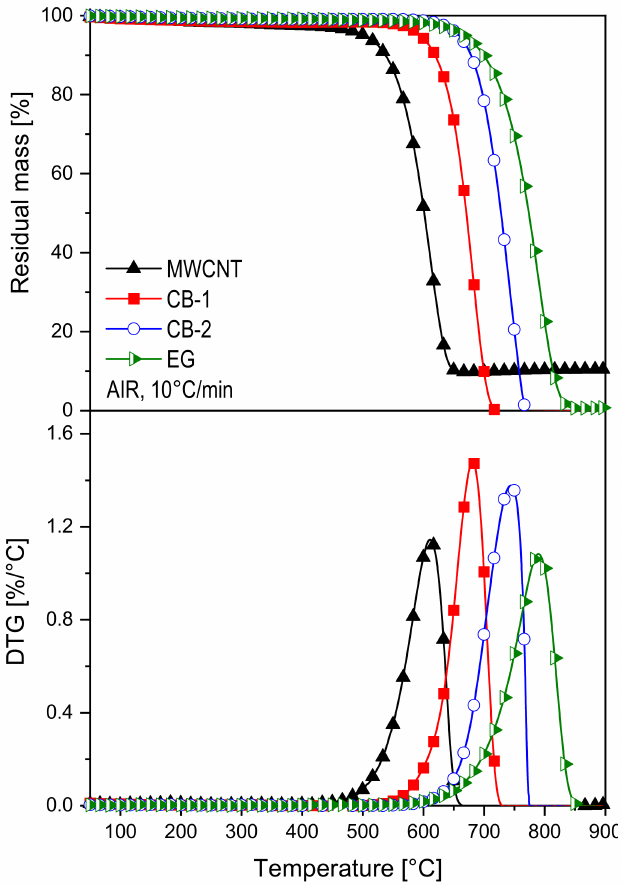
Figure 1. Thermogravimetric analysis of the carbon nanostructures in oxidative